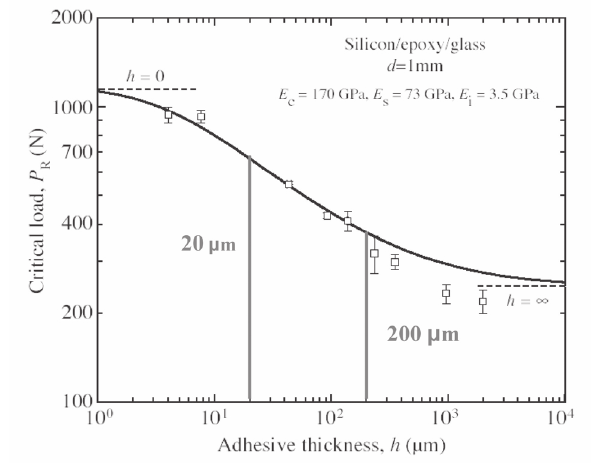
FIGURE 9 - Critical load for flexural radial cracking, P silicon epoxy bonded to glass with variation in the epoxy layer thickness. The curve is a theoretical fit